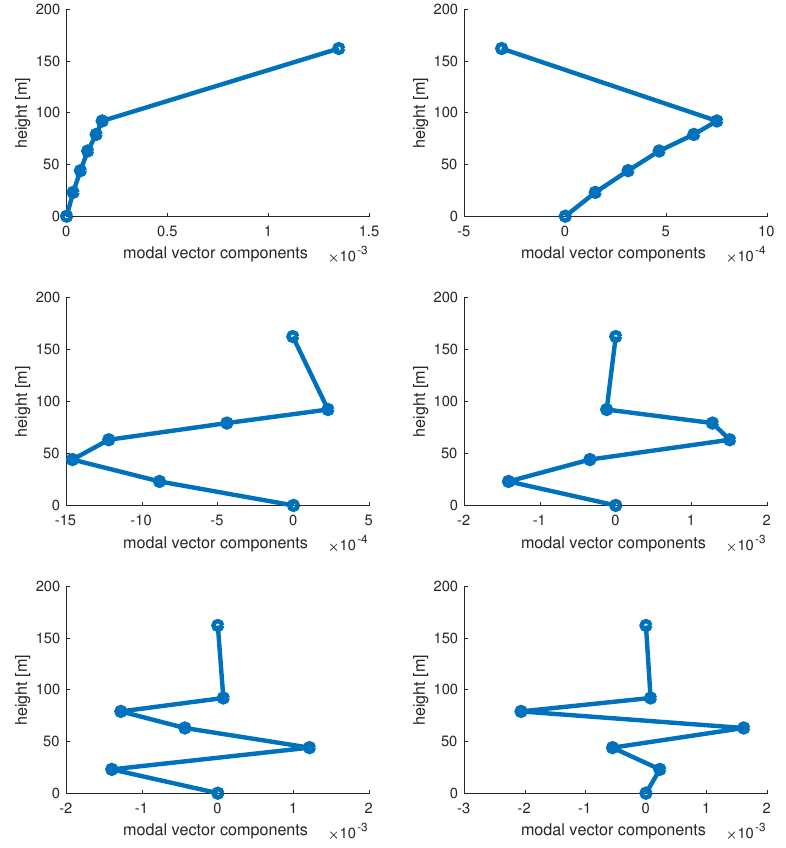
Figure 23. The 2-MW configuration vibrational